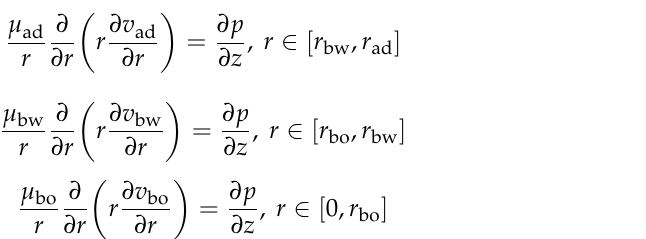
Figure 8. The schematic diagram of three flo w regions of the “ liquid – liquid slip” model. The governing equation of each flow region can be expressed as: